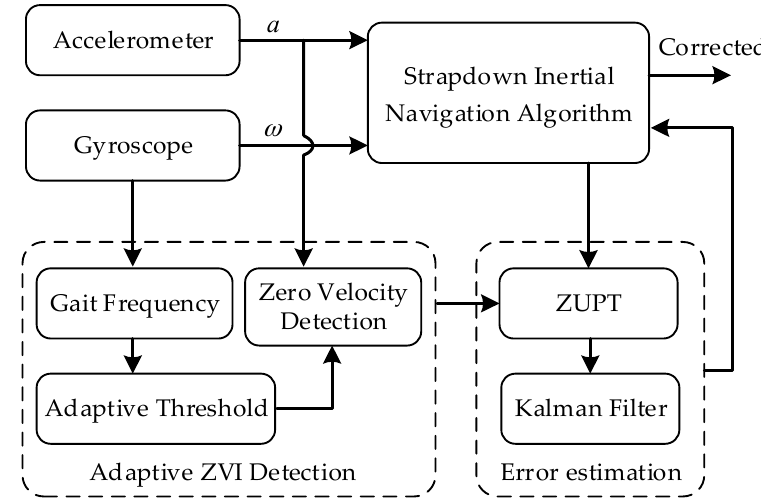
Figure 1. Pedestrian navigation algorithm architecture.